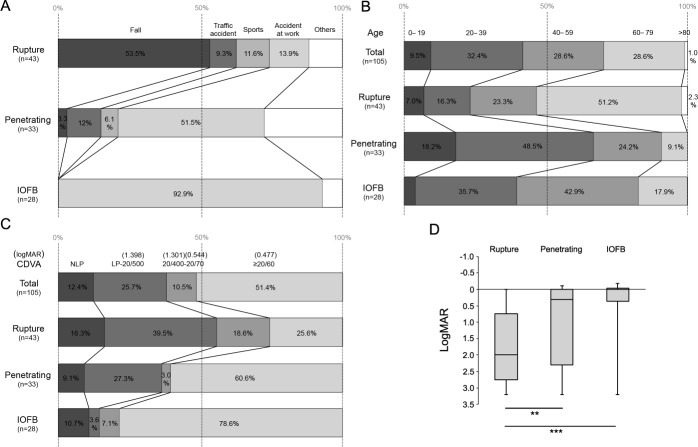
Main causes, age of the patients, and final visual outcome of ocular injuries.(A) Falls were the major cause (53.5%) of rupture injury. Accidents at work were major causes of penetrating injuries and IOFB, whereas falls were not or less relevant. (B) In the penetrating and IOFB groups, more patients were aged 0 to 19 years, 20 to 39 years, and 40 to 59 years, whereas in the ruptured ocular group, more patients were aged 60 years or older. (C) Among patients with penetrating and IOFB injuries, more than 60% of the eyes attained a visual acuity of 20/60 or more. On the other hand, more than 50% of the eyes with rupture injuries attained a final visual outcome of NLP or LP of 20/500. (D) There was a significant difference in the logarithm of the minimum angle of resolution (logMAR) values between ruptured eyes and eyes with penetrating or IOFB injuries. Error bars indicate whole range of distribution. **P = 0.0017, ***P < 0.001 IOFB, intraocular foreign body; LP, light perception; NLP, no light perception.